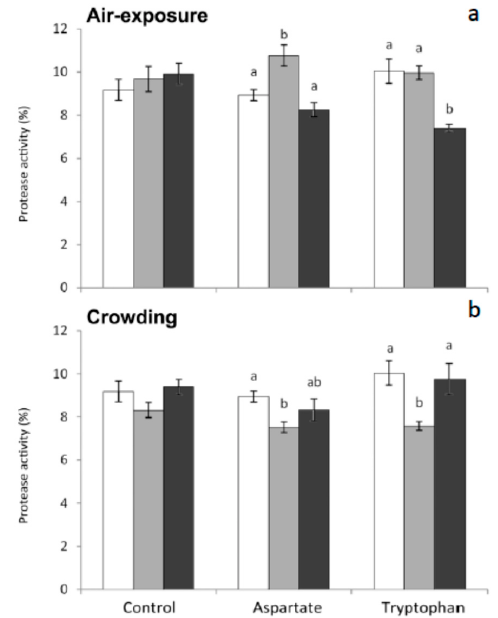
Figure 1. Protease activity (%) in fish stressed by ( a ) air-exposure or ( b ) crowding. Results are shown as mean ± standard error. Different letters indicate significant differences among non-stressed fish (white bars), 1 h post stress (grey bars) and 6 h post stress (black bars). Differences were considered significant when p < 0.05.